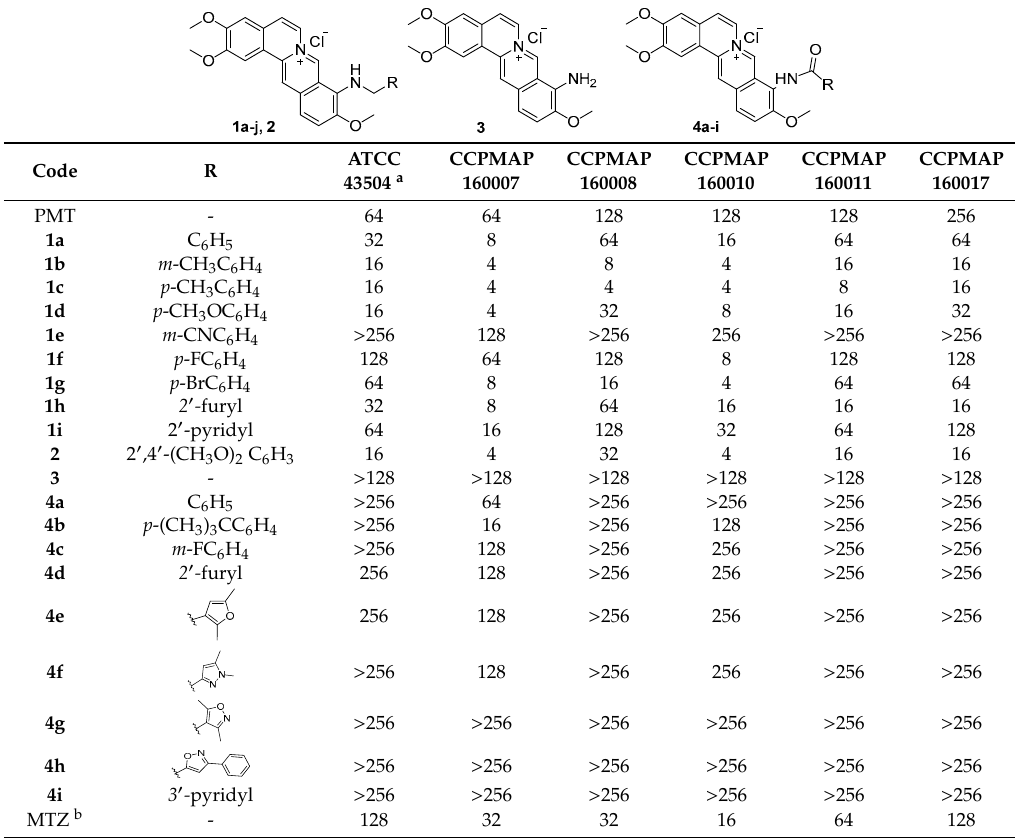
Table 1. Antimicrobial activities of the target compounds against metronidazole (MTZ)-resistant H. pylori strains (minimum inhibitory concentration (MIC), μ g/mL).